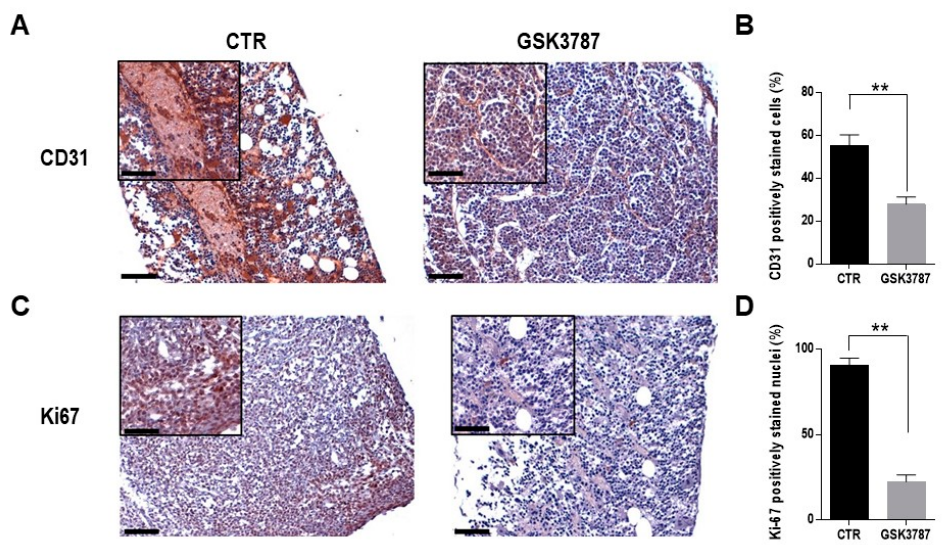
Figure 7. PPAR β / δ inhibition reduces MM angiogenesis. NOD/SCID mice bearing RPMI-8226 intratibial xenografts were treated with GSK3787 ( n = 5) or vehicle ( n = 5) for 6 days. ( A , B ) Tumor sections stained for CD31 and quantification of CD31-positive murine endothelial cells. ( C , D ) Tumor sections stained for Ki-67 and quantification of positively stained nuclei. The histograms show the average results from five slides for each condition and five fields per slide. ** p <0.01, Mann–Whitney U test. Scale bar = 100 µm.